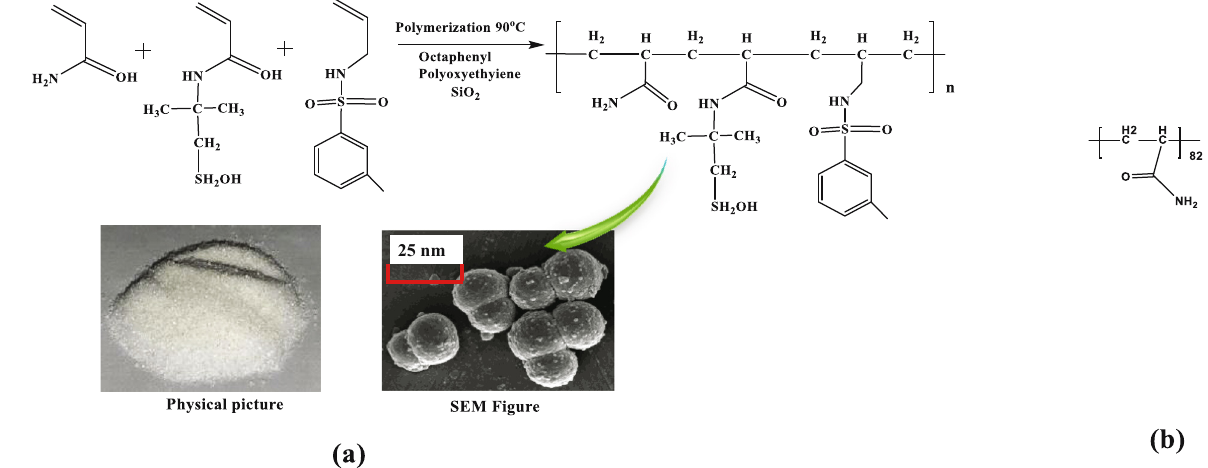
Figure 2: Preparation process and SEM microscopic images of nano - silica gelling agent CTG - 1 and commercially available gel